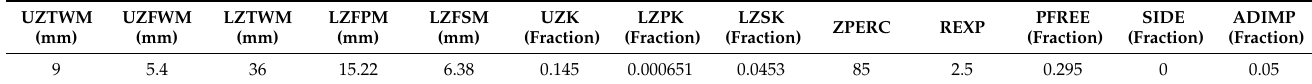
Table 1. Parameters of the Sacramento (SAC) soil water accounting model for the